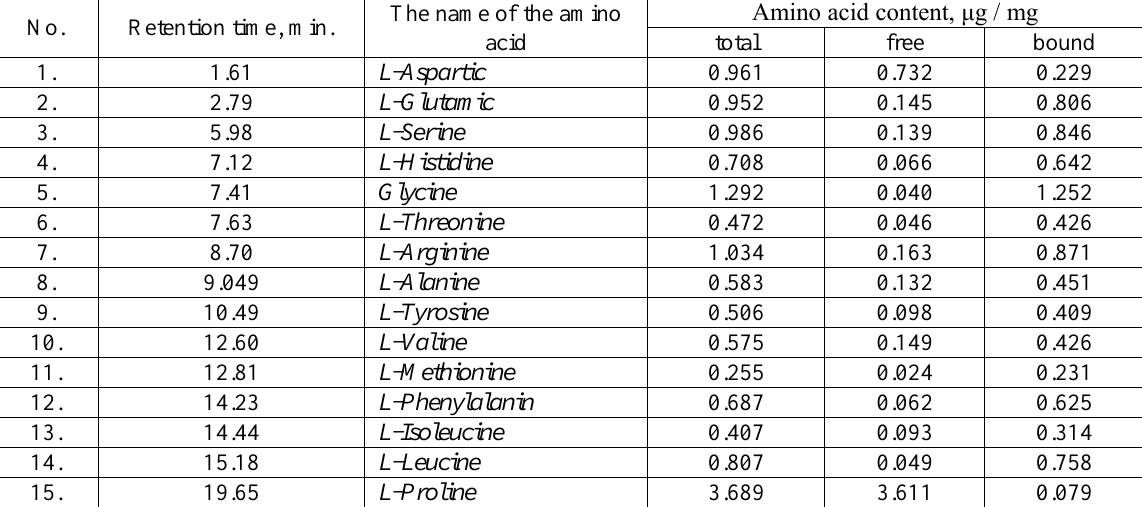
Fig. 1. Chromatogram definition of amino acids in the shrubby Sophora roots Results of determining the content of amino acids in the shrubby Sophora